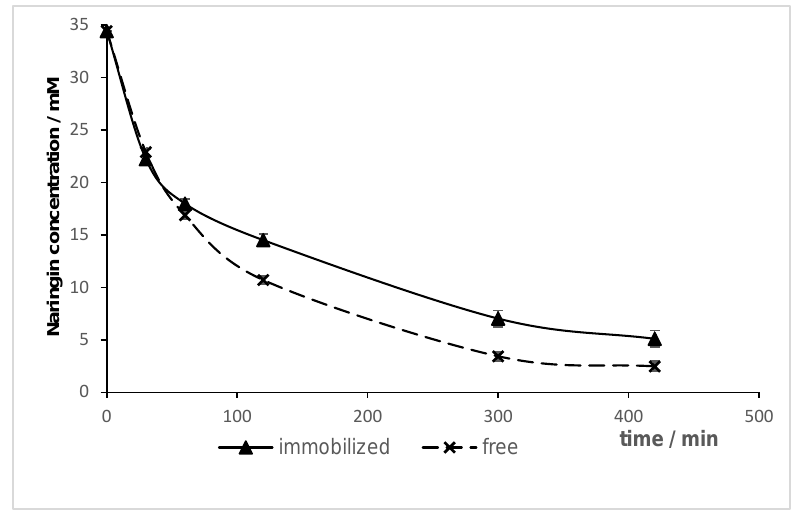
Figure 5. Residual concentration of naringin after hydrolysis as function of time.